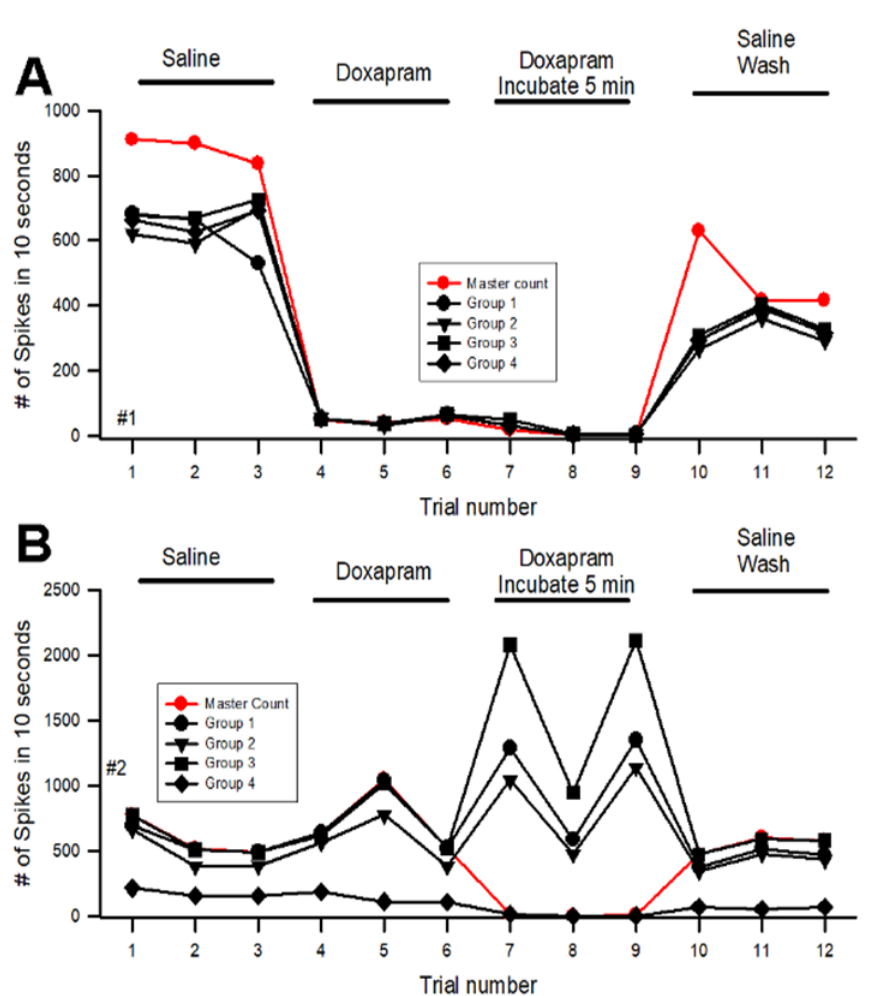
Figure A2. Four groups of different participants, with two people per group, analyzed the same data sets (A #1 and B #2). ( A ) The four groups who analyzed the #1 data set fits well with the analysis from a master in analysis, whose counts are indicated by the red line. The master analyzed all data sets in the study. ( B ) The participants deviated from the master in analysis for three of the four groups in the condition where the doxapram had been incubated for 5 min. The other experimental conditions followed a similar trend as that of the master.